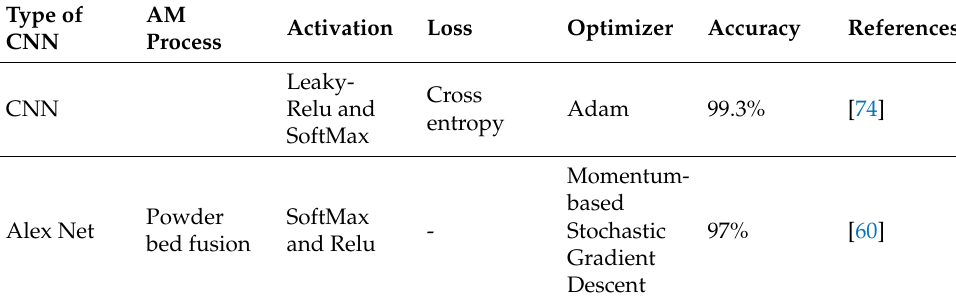
Figure 9. Basic architecture of CNN. Table 4. Summary of various literature on the related